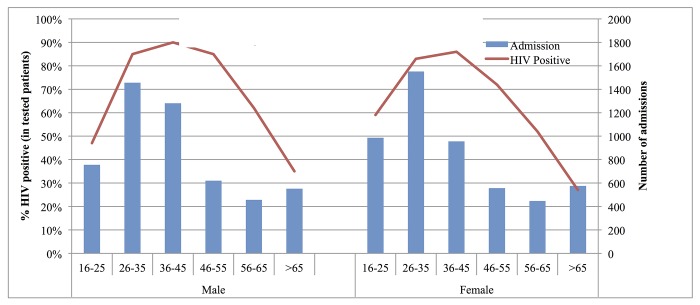
HIV Prevalence by age and sex in medical ward in-patients, Blantyre, Malawi, January 2013- December 2014.The red line represents the percent of admitted patients that are HIV infected. The blue bars represent the number of patients admitted.